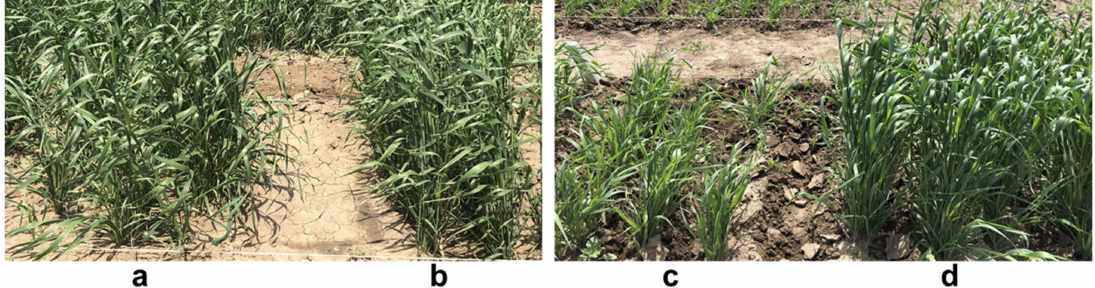
Figure 7. Images of plants from parental and breeding lines from the segregating population No. 18-6 at tillering stage grown in the research field trial in northern Kazakhstan in 2020, as follows. ( a ) breeding line No. 18-6-37; ( b ) 18-4, spelt wheat; ( c ) 18-5, bread wheat; ( d ) breeding line No. ♀ ♂